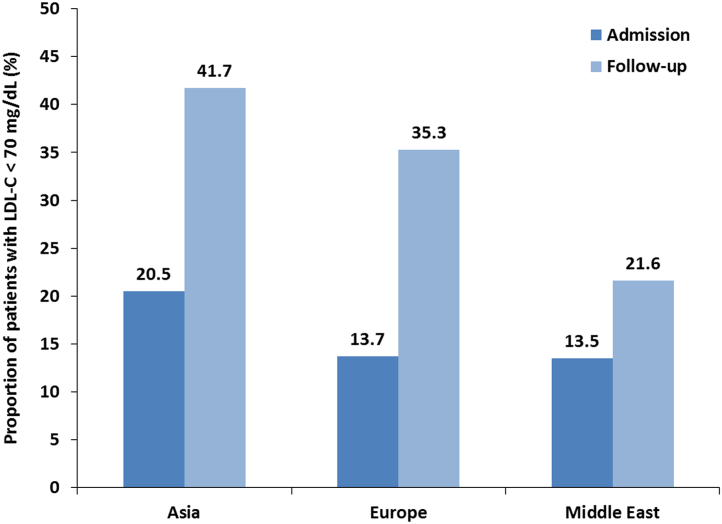
LDL-C target value attainment by region. Target value attainment rates were calculated for the 1,071 patients with LDL-C data at both time points.